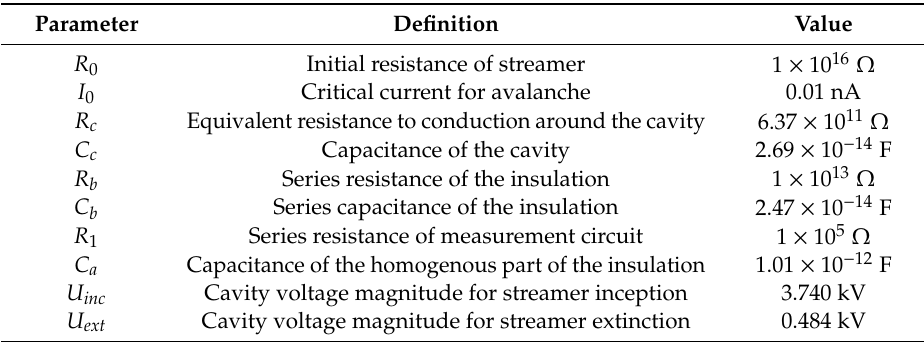
Table 8. Parameter definition for the three-capacitance model.